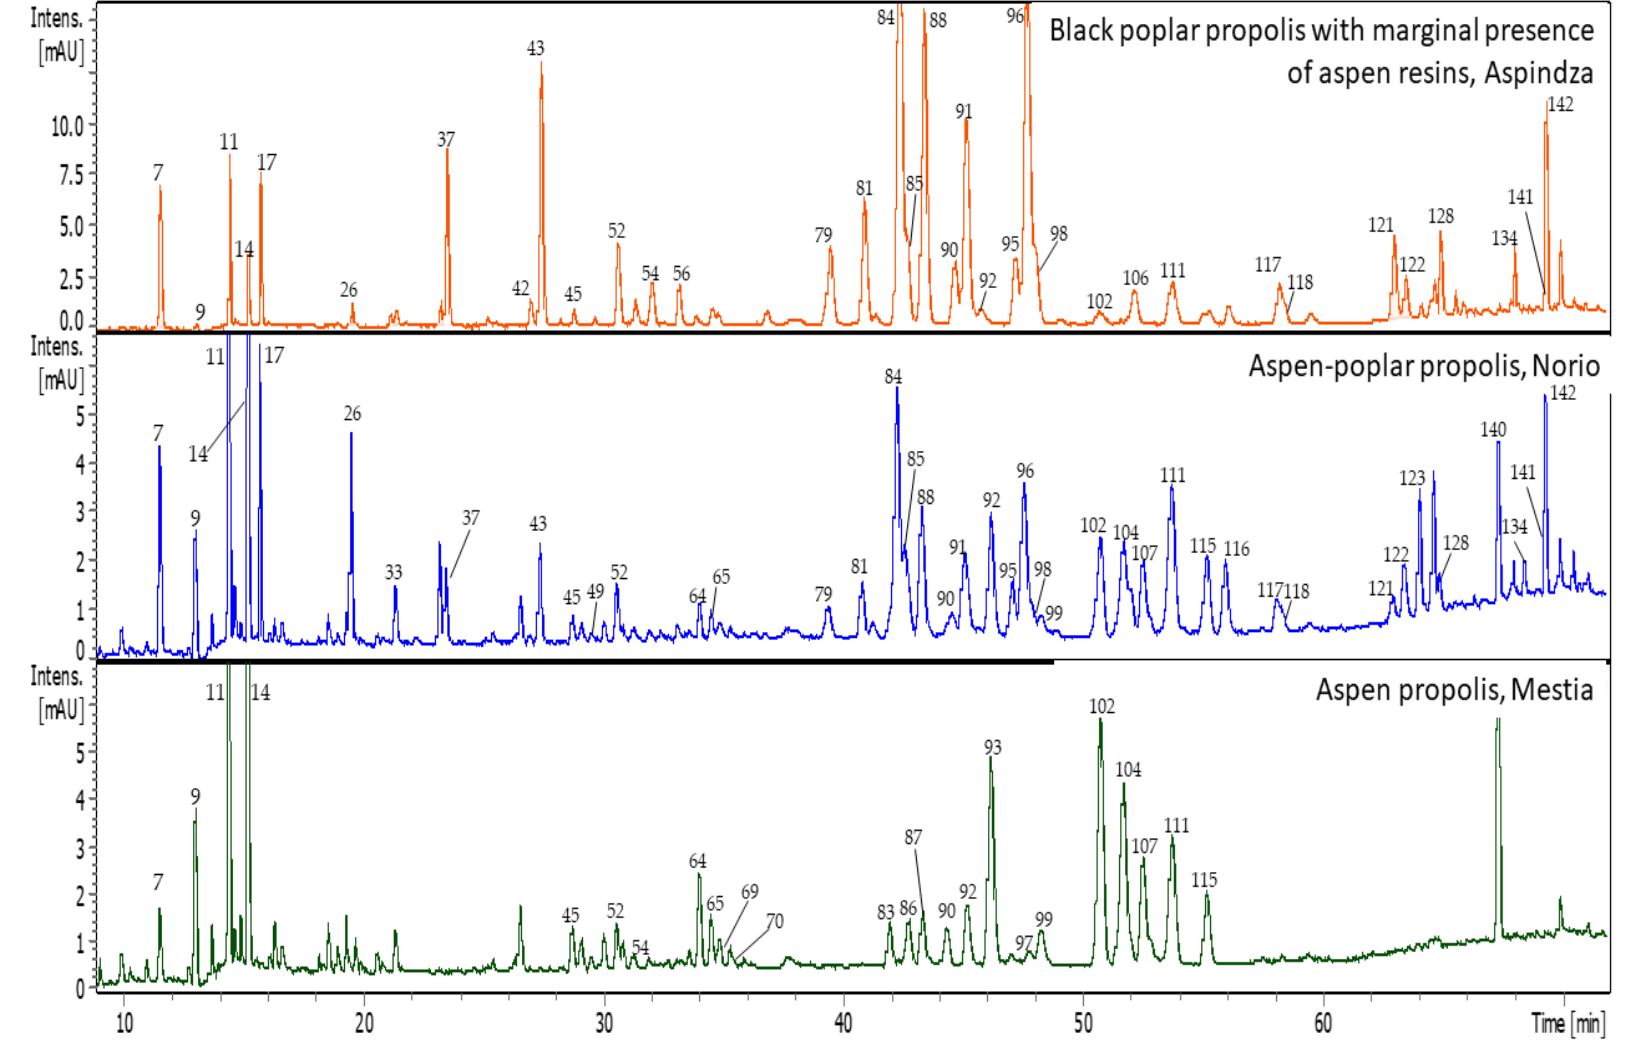
Figure 1. Representative UHPLC-DAD chromatograms of Georgian types of propolis at 280 nm.